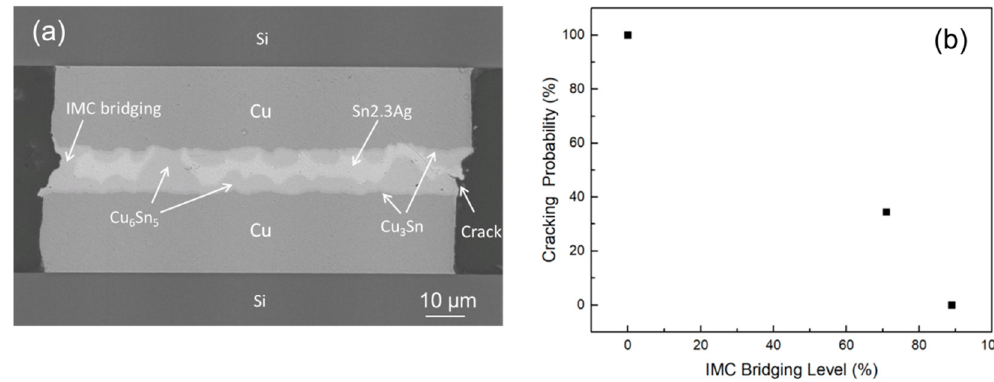
Figure 7. ( a ) Cross-sectional SEM BEI of the partial IMC-bridging Cu/solder/Cu microbump after a TCT for 1000 cycles and ( b ) the correlation of the observed cracking possibility and the IMC bridging level. Arrows designate the IMCs.